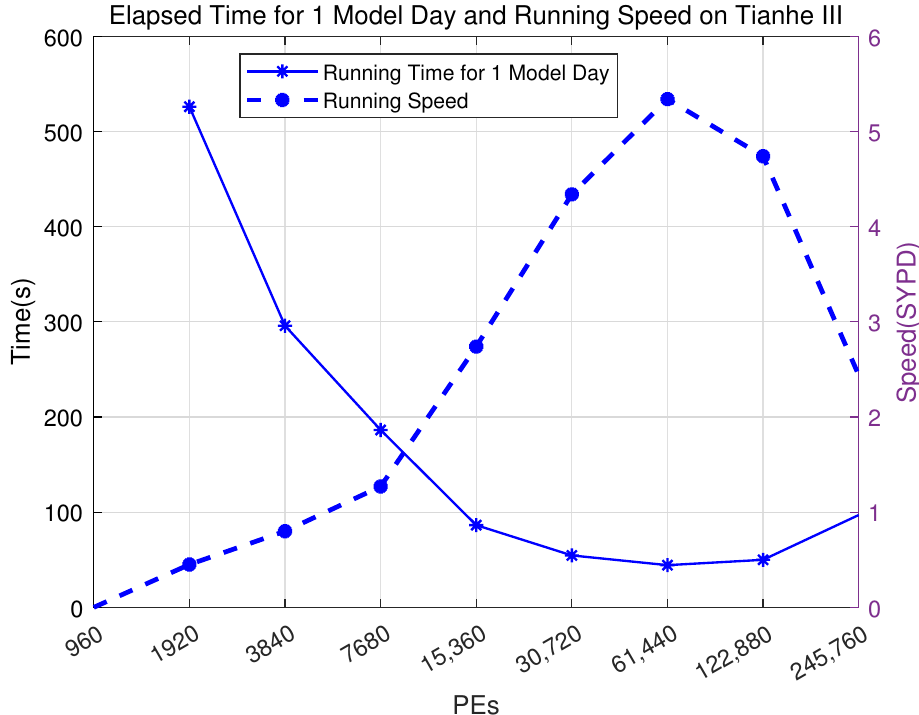
Figure 10. Elapsed time and speed of LICOM on Tianhe III.